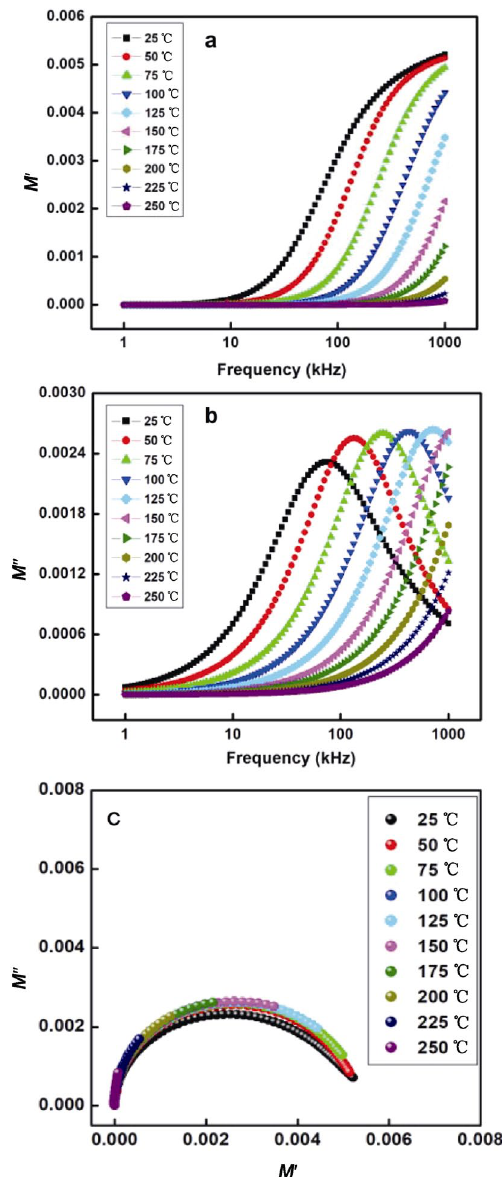
Fig. 8 Variation of (a) M ′ , (b) M ″ with frequency at selected temperatures, and (c) variation of M ' with M ″ at selected